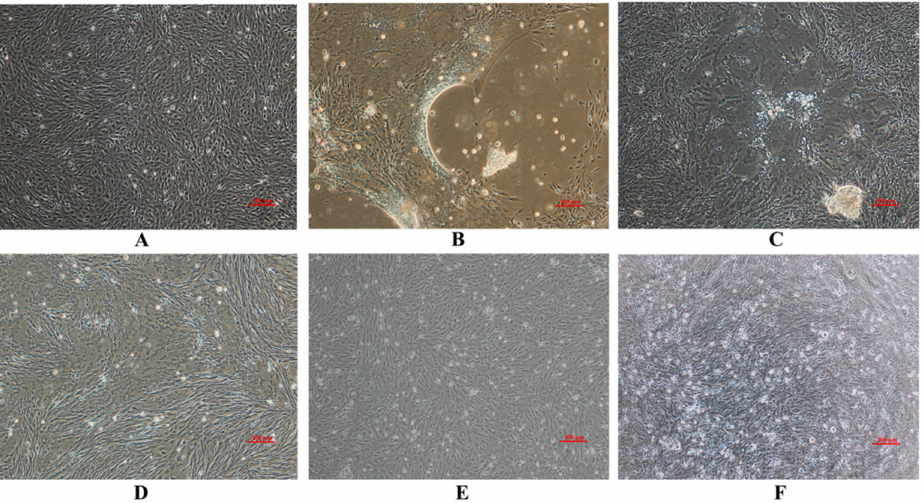
Figure 1. The CPE of C. idella kidney (CIK) cells infected with GCRV-GZ1208, 873, HZ08, HGDRV, and GSRV. ( A ) Uninfected CIK cells and cells infected with ( B ) GCRV-GZ1208 at 2 days post-infection (dpi), ( C ) GCRV-873 at 2 dpi, ( D ) GSRV at 2 dpi, ( E ) GCRV-HZ08 at 5 dpi, ( F ) HDGRV at 5